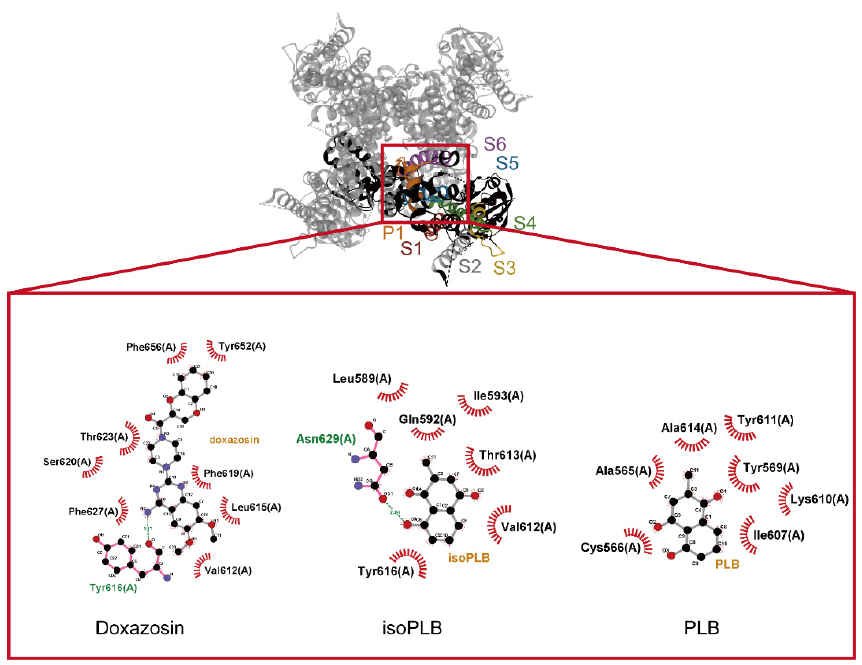
Figure 10. Docking results of hERG and doxazosin, isoPLB, and PLB. The protein structure of hERG was obtained from PDB (PDB ID: 5VA1) and the compound structure of doxazosin, isoPLB, and PLB were obtained from PubChem (compound CID: 3157, 10205, 375105). The structure of hERG amino acid 520–660 was extracted through PyMOL and then docked with three compounds through PyRx. The diagrams of interaction between hERG and compounds were generated by LigPlot+. The red arcs with spokes radiating toward the ligand represent hydrophobic contacts and green dotted lines represent hydrogen